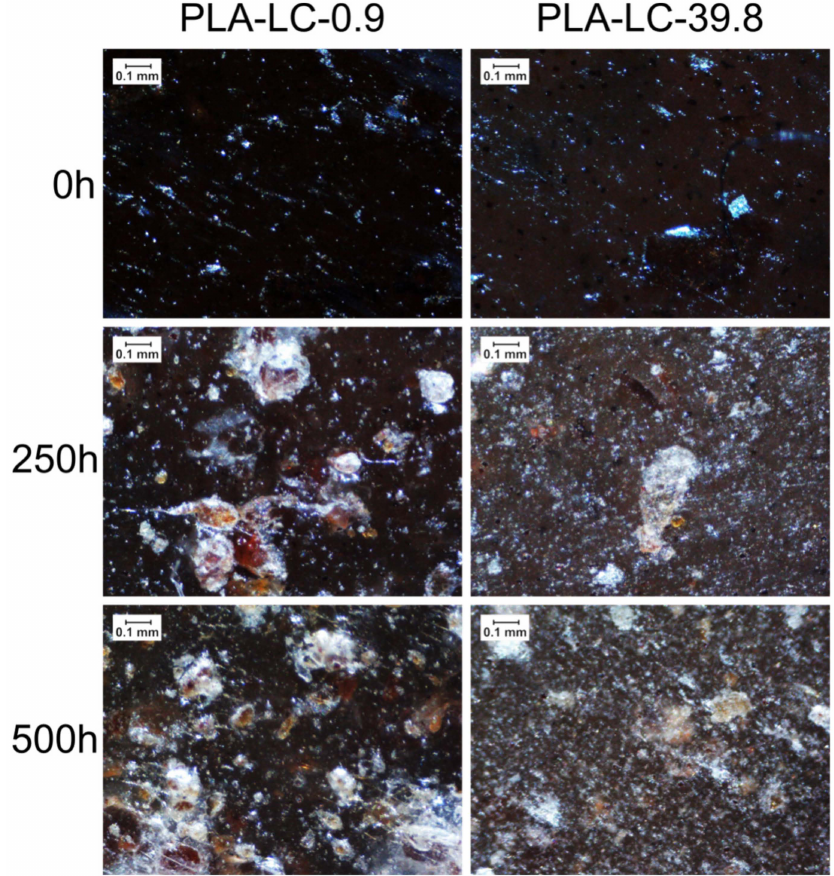
Figure 3. Surfaces of polylactide-linseed cake (PLA-LC)-0.9 and PLA-LC-39.8 samples weathered for di ff erent